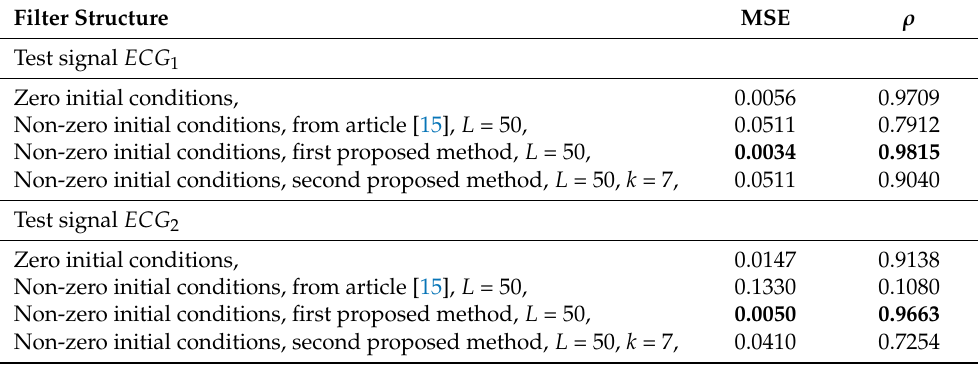
Table 2. Values of filtration quality indicators acquired during simulation studies.